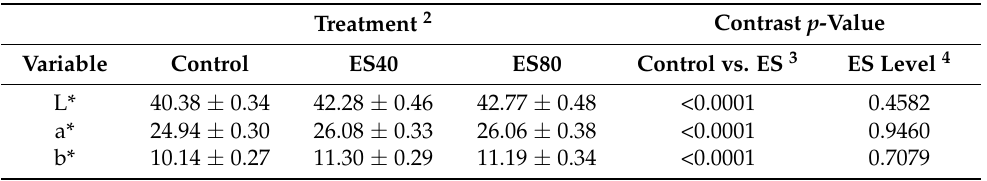
Table 4. Instrumental color values of longissimus muscle from beef carcasses subjected to low-voltage electrical stimulation for 60 s in 4 s on, 2 s off intervals prior to chilling